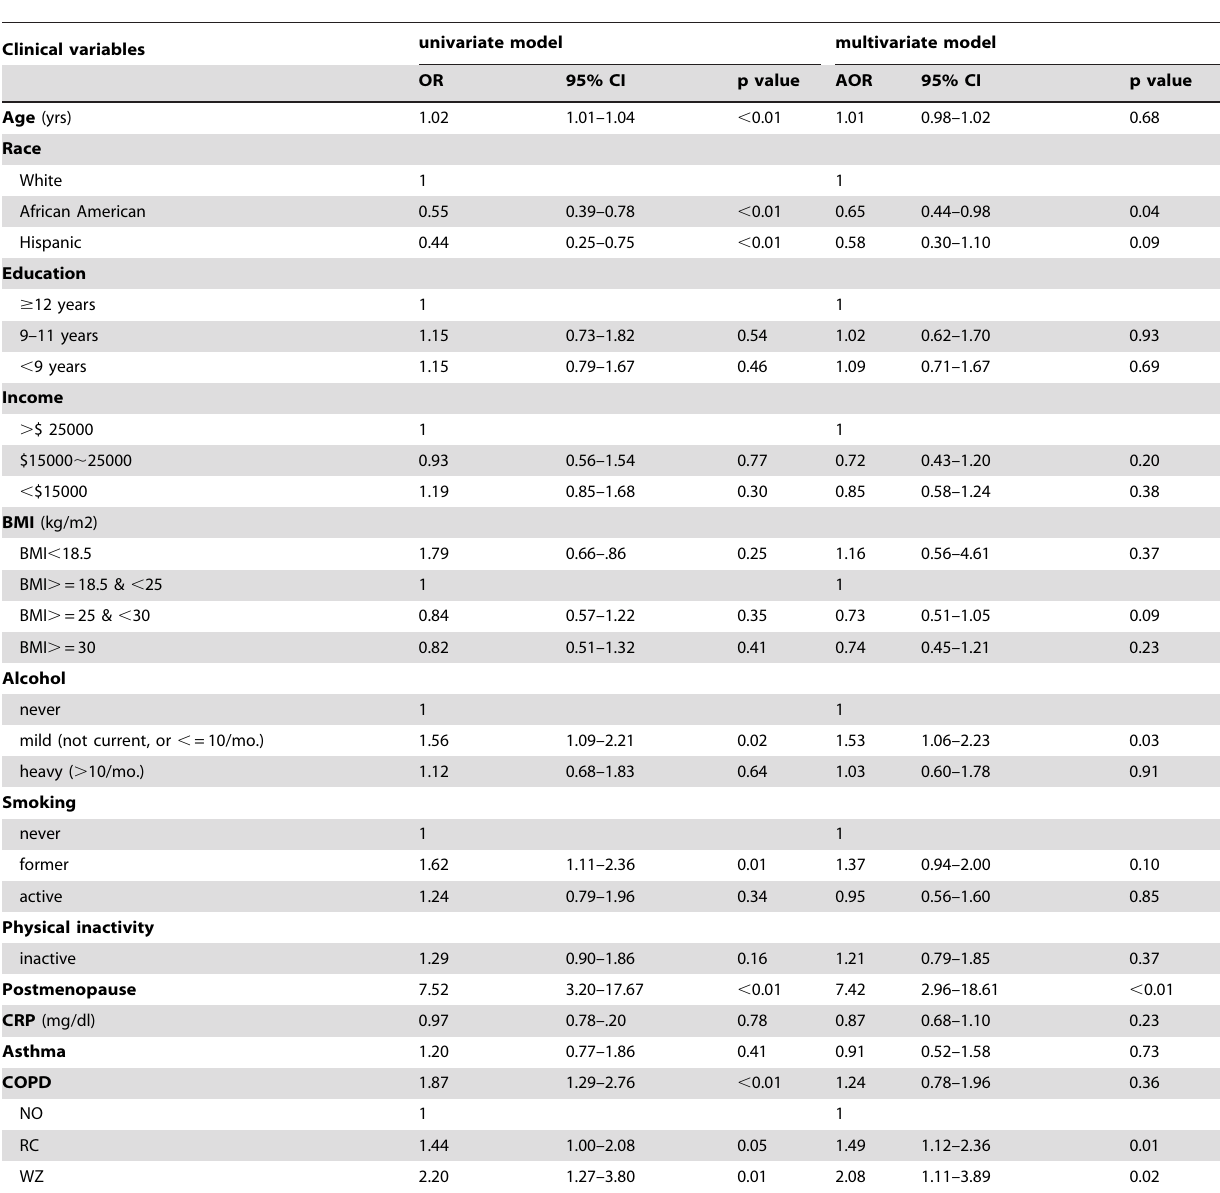
Table 2. Univariate and multivariate analyses of cancer risk factors among female study